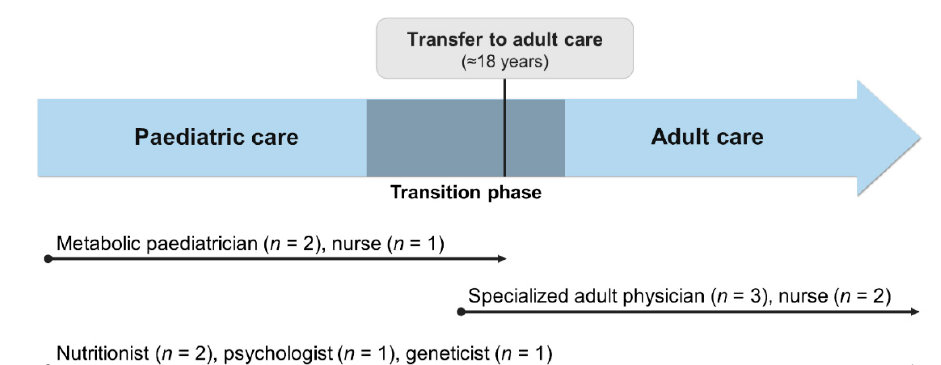
Figure 1. Representation of the current transition process and the multidisciplinary approach throughout all life stages at Centro Hospitalar Universitário do Porto . As shown above, only the medical and nursing staff change during transition to adult services. The same nutritionists, psychologist and geneticist are included in both paediatric and adult teams and are responsible for the follow-up of patients at all ages.